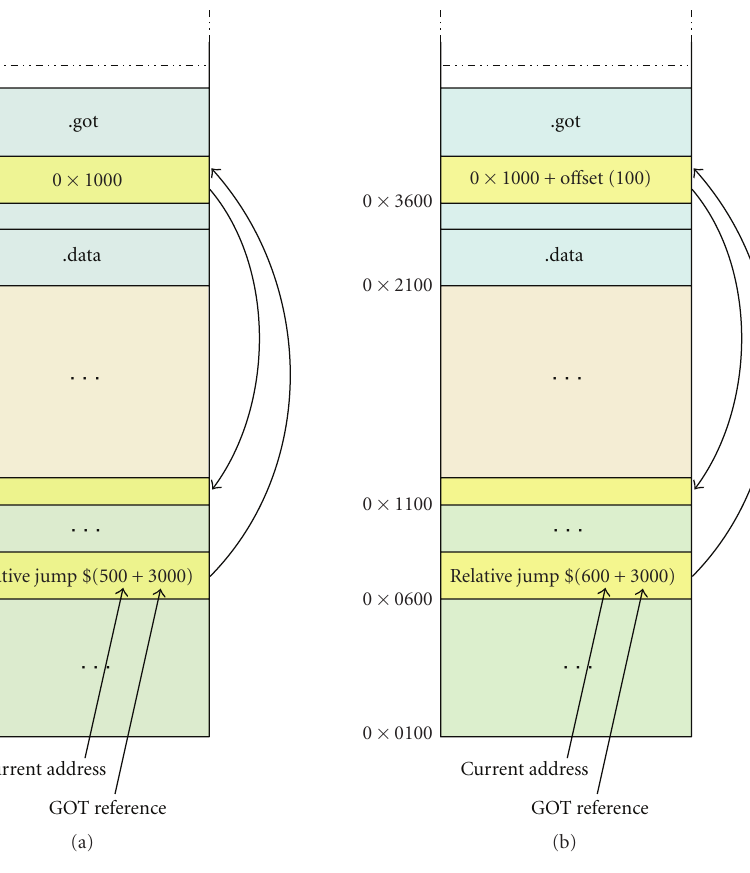
Figure 10: Relative jumps with GOT.